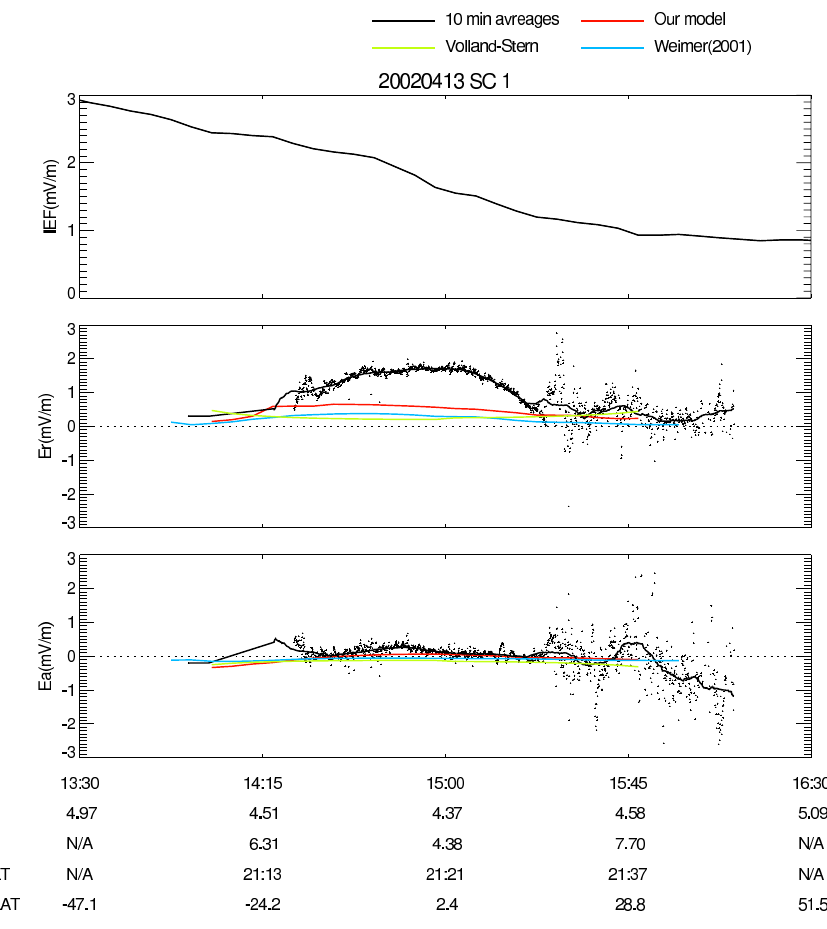
Fig. 8. Comparison between electric fields from original Cluster (SC 1) measurement, its running average, our model, Volland-Stern model, and Weimer (2001) model for 13 April 2002. The format of this figure is the same as Fig.